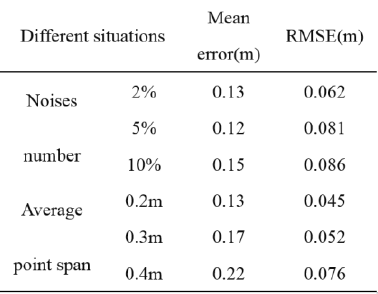
Table 4. Registration accuracy of different